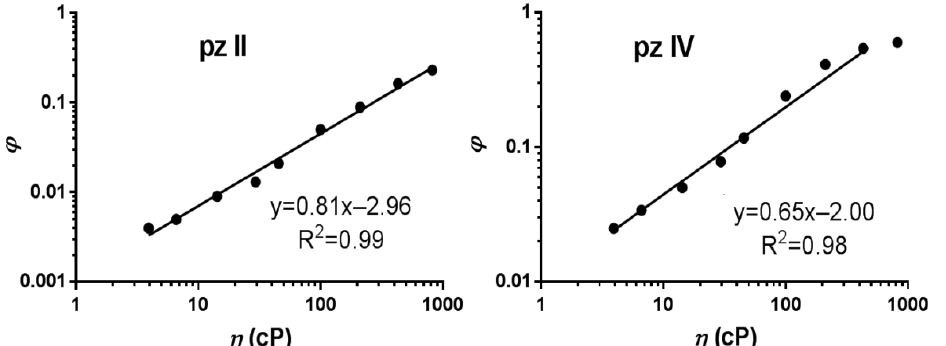
Figure 4. Dependence of the fluorescence quantum yield ( ϕ ) of pz II and pz IV on the viscosity ( η ) measured in ethanol–glycerol solutions. The data followed the Förster–Hoffmann equation with coefficients of viscosity sensitivity of 0.81 and 0.65, respectively.